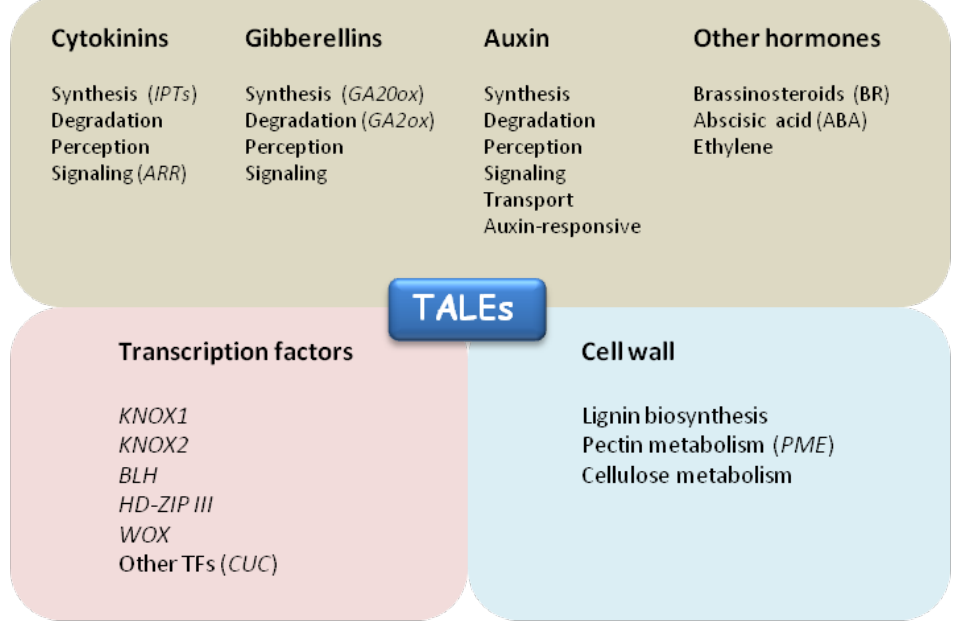
Figure 6. Functional categories of TALE target genes. Putative TALE direct targets belong to three main functional categories: hormonal pathways (grey box), transcriptional regulation (pink box) and cell wall metabolism (light blue box). KNOX1 positively regulate cytokinin biosynthesis and signaling through induction of ISOPENTENYL TRANSFERASE (IPTs) and ARABIDOPSIS RESPONSE REGULATORS ( ARRs ) genes. Low active gibberellins levels are maintained by KNOX1 through repression of GA biosynthetic genes ( GA20ox ) and induction of GA degradation by GA2ox genes. CUC1 TF has been identified as a direct target of STM in Arabidopsis. Arabidopsis KNAT1/BP was shown to repress several genes involved in lignin biosinthesis. Arabidopsis BLH9/BLR negatively regulate PECTIN METHYLESTERASE 5 ( PME5) gene to repress cell expansion in the SAM. Recent studies of ChIP-seq and RNA-seq identified KN1 modulated